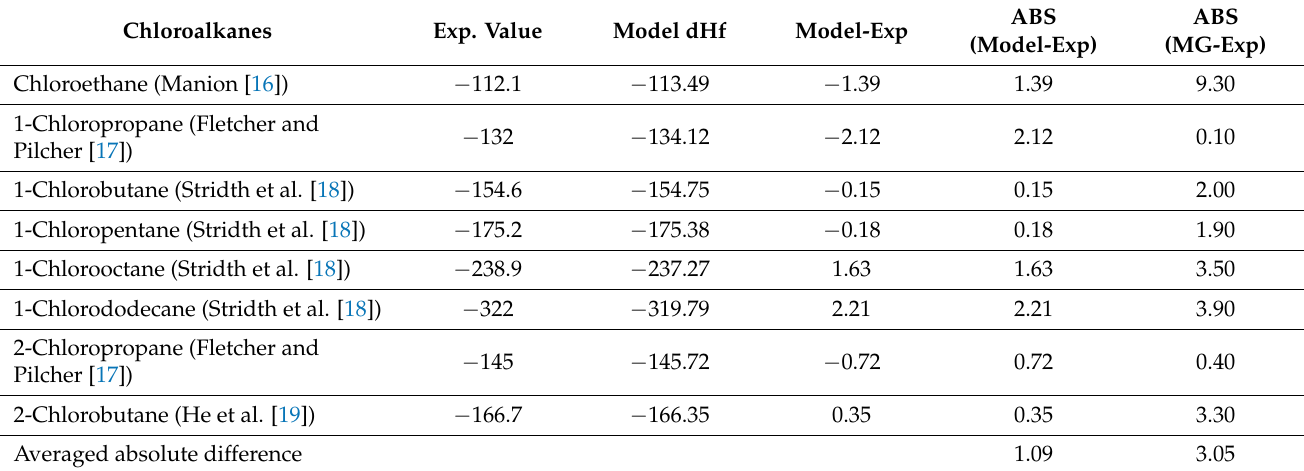
Table 2. Experimental and model values for mono-chloroalkanes. All values in kJ/mol. The origin of the experimental values is given in column 1. Values for the Marrero–Gani method evaluated through the ICAS23 software are shown for